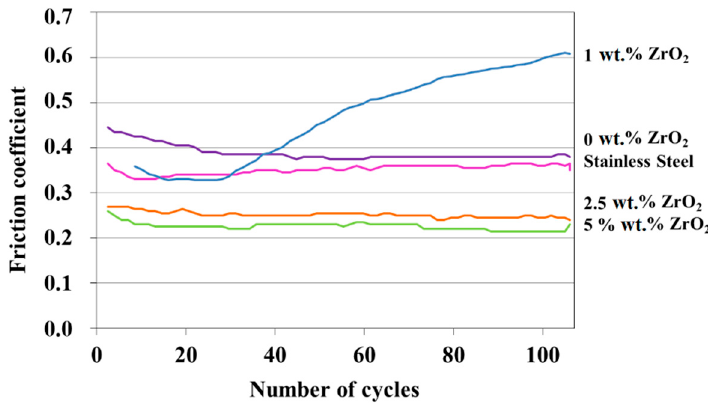
Figure 9. Friction coefficients of each surface obtained during wear test, as a function of number of cycles.